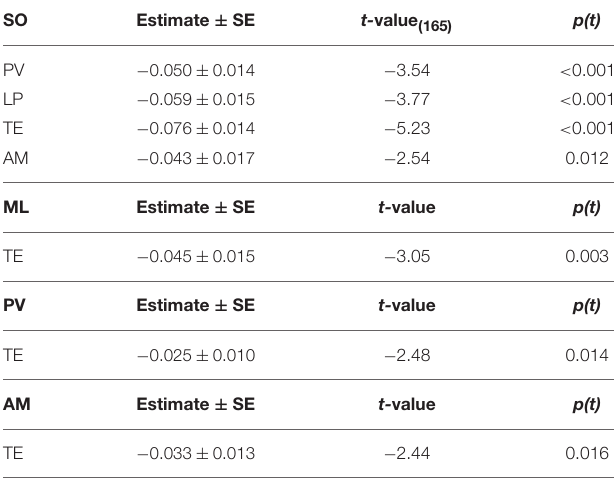
( Table 5 ). Significant predictive factors (VP, SH, and DL) were used to fit the GER which was better predicted by VP as the first term, followed either by SH or DL independently of the term. As the third term was not significant, GER = VP + SH + Site or else GER = VP + DL + Site, where GER is the response variable, VP, SH, and DL are fixed effects and Site the random